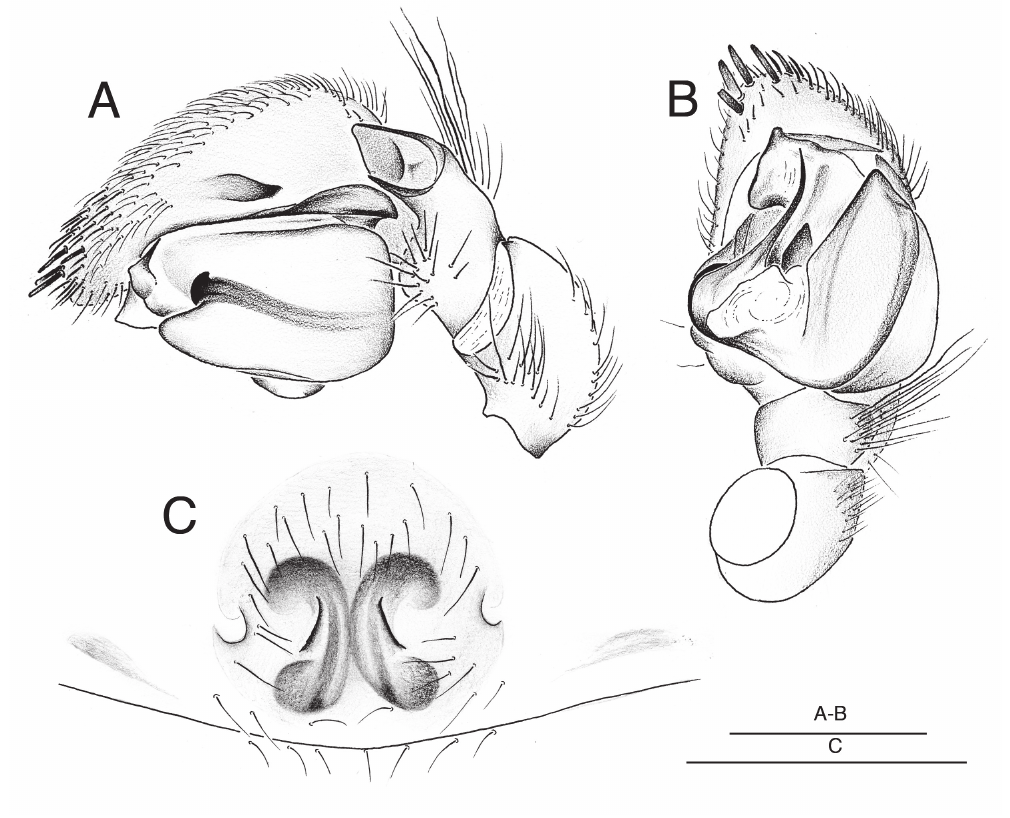
Fig. 12. Ballomma neethlingi gen. et sp. nov. A–B . ♂ (NCA 76/1048) C . Holotype, ♀. A . Male palp, retrolateral view. B . As preceding, ventral view. C . epigyne, ventral view. Scale bars: 0.5